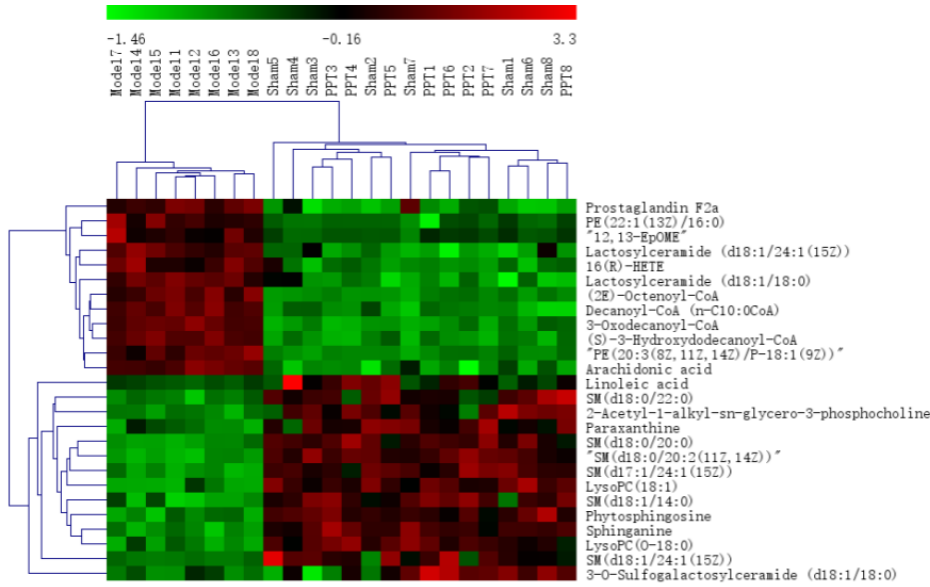
Figure 7. The heatmap of the potential metabolites. Table 4. The results from the metabolic pathways of differential metabolites.